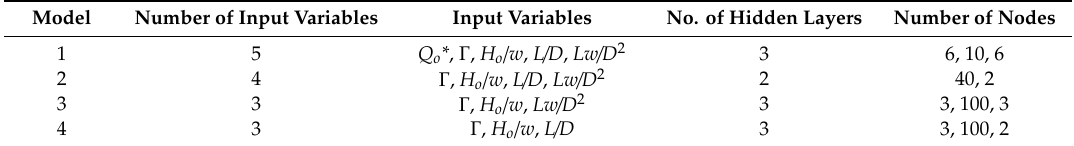
Table 1. Multilayer perceptron (MLP) models features. The input variables are defined in Section